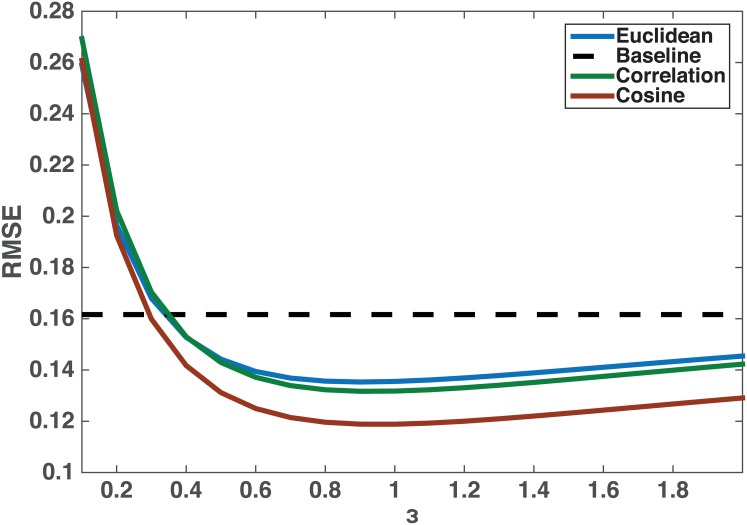
Sensitivity of our metric with respect to ξ and ϵ.The proposed VA-index outperforms the baseline extension of assortativity coefficient. Furthermore, it does not appear sensitive to the choice of ϵ (Eq (5)) and/or similarity metric.